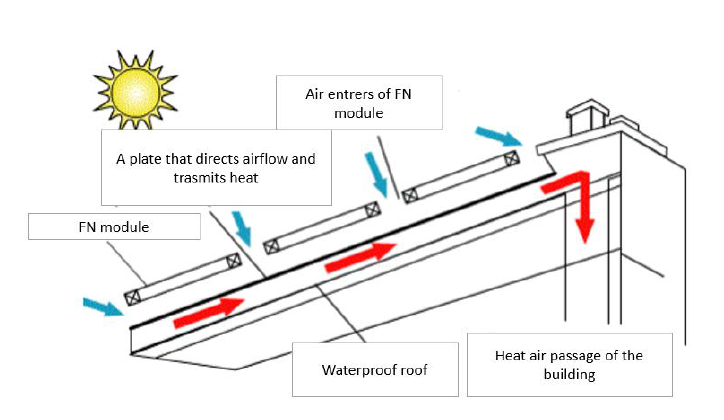
Figure 4. Photovoltaic air-cooled modules